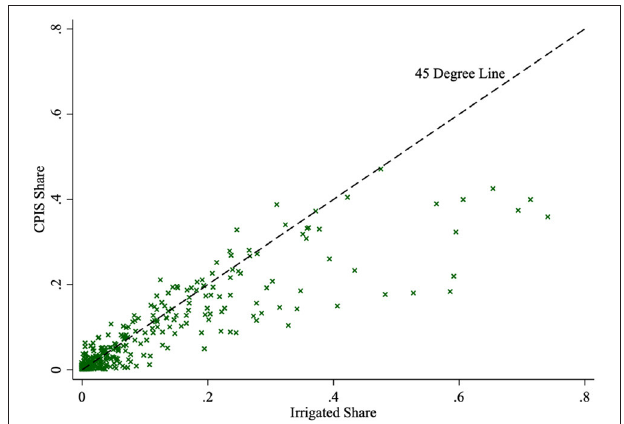
FIGURE 4 | Irrigation share vs. CPIS share, Ogallala. This provides a scatter plot of irrigated share, reported in the 2007 Census, and the CPIS share calculated, from our model, for the Ogallala counties (within 100km of the aquifer